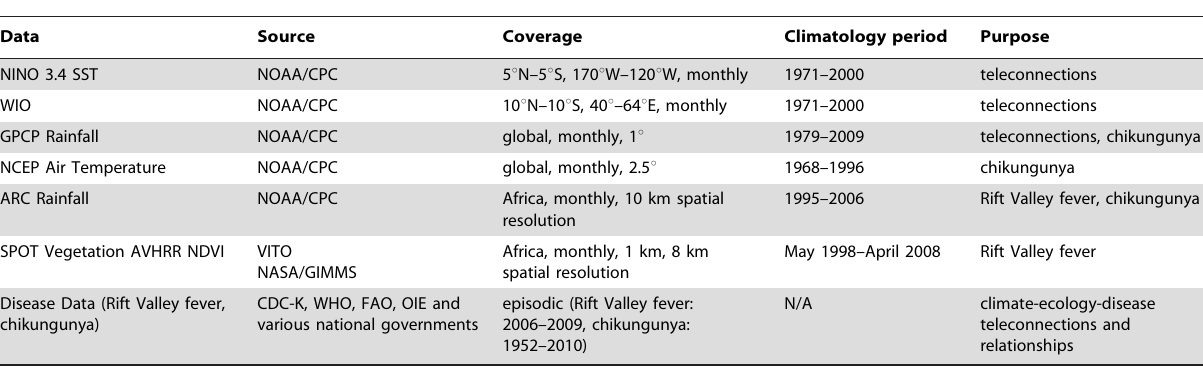
Table 1. Climate and disease data sets used in the